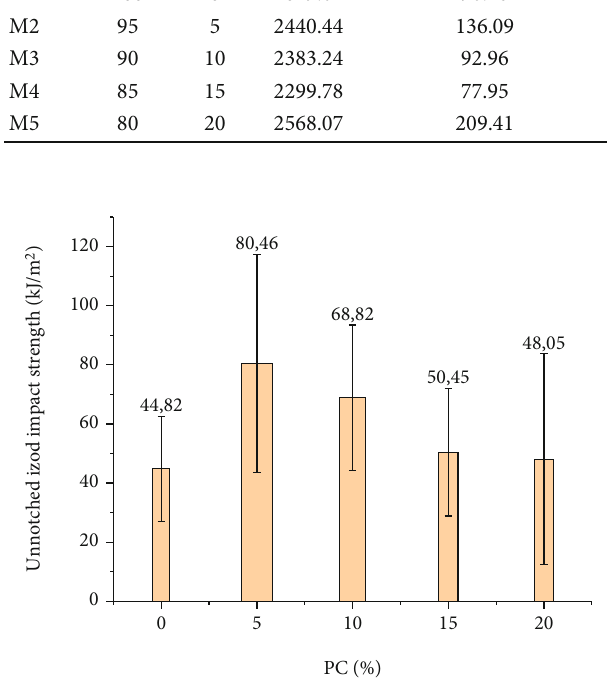
Figure 4: The average unnotched impact strength of test samples.